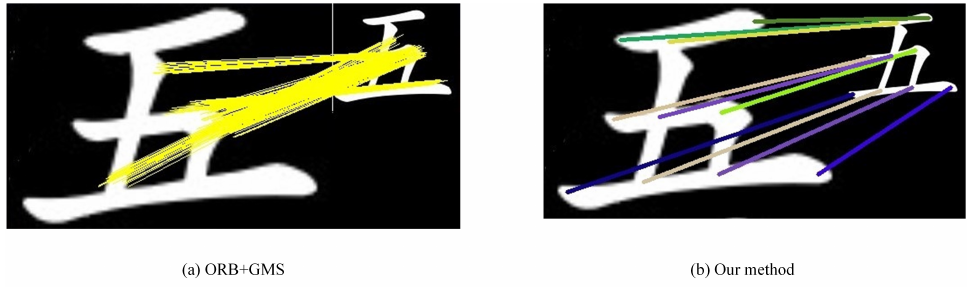
Figure 9. ORB and GMS have difficulty in this case because the color and texture features of Chinese characters are not obvious. Our method can perform accurate feature point detection and eliminate false matches with neighborhood